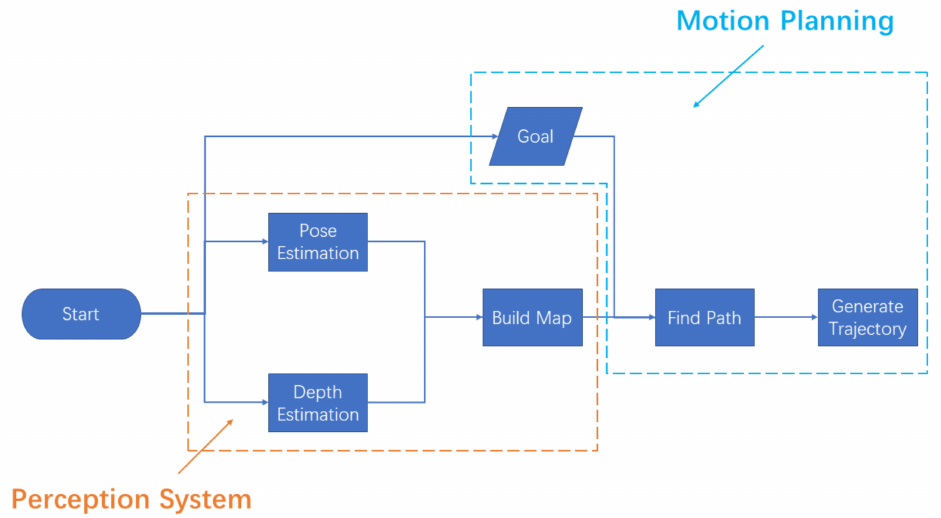
Figure 1. Schematic of the framework of the autonomous motion